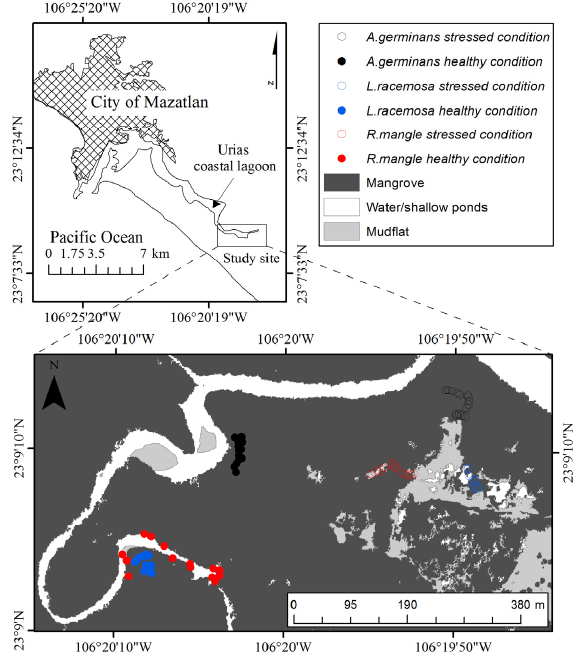
Figure 1. Study site within the Mexican Pacific. Symbols in the legend indicate sample locations.